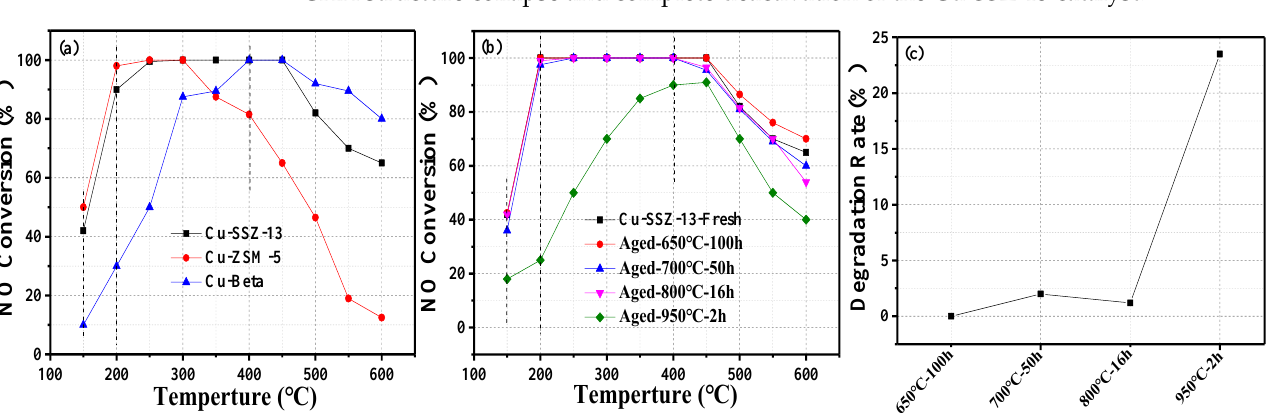
Figure 1. NO conversion as a function of temperature in the standard SCR reaction over Cu-SSZ-13, Cu-ZSM-5 and Cu-Beta catalysts: ( a ) fresh activity of the Cu based zeolites; ( b ) NO conversion of the Cu-SSZ-13 before and after hydrothermal aging; and ( c ) deterioration rate of the Cu-SSZ-13.